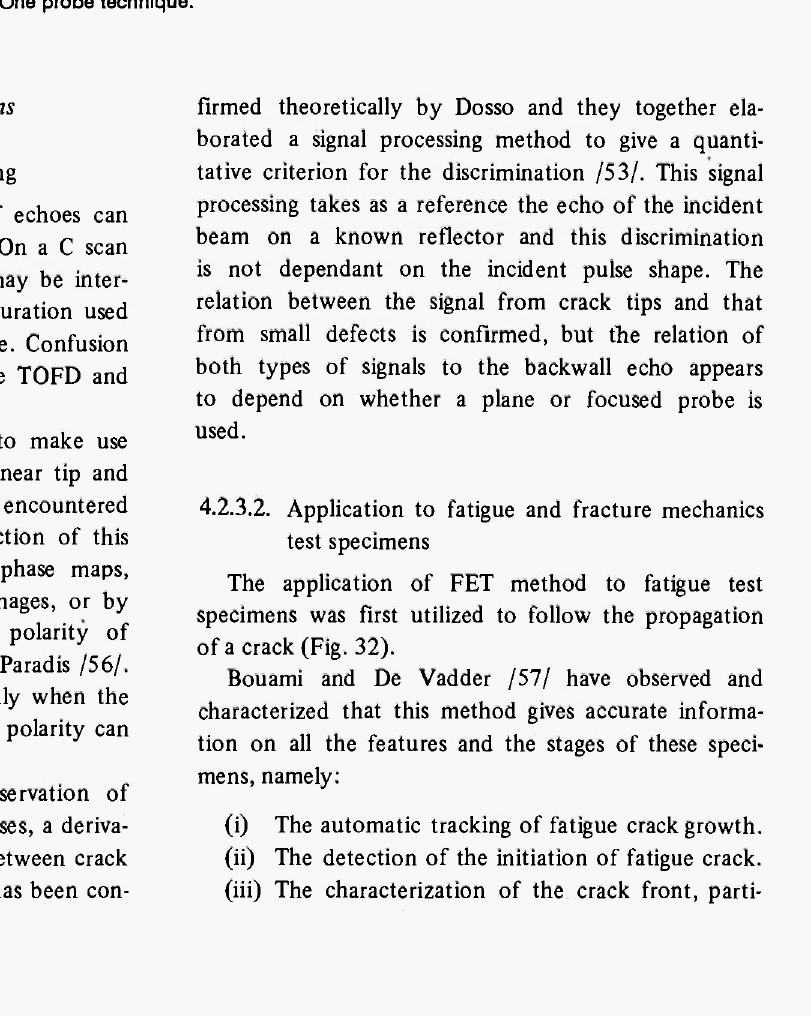
Fig. 30: Intensity and Phase B-Scans of an artificial crack. The map is perpendicular to the crack. The phase B-Scan displays the inversion of polarity between the tips. One probe